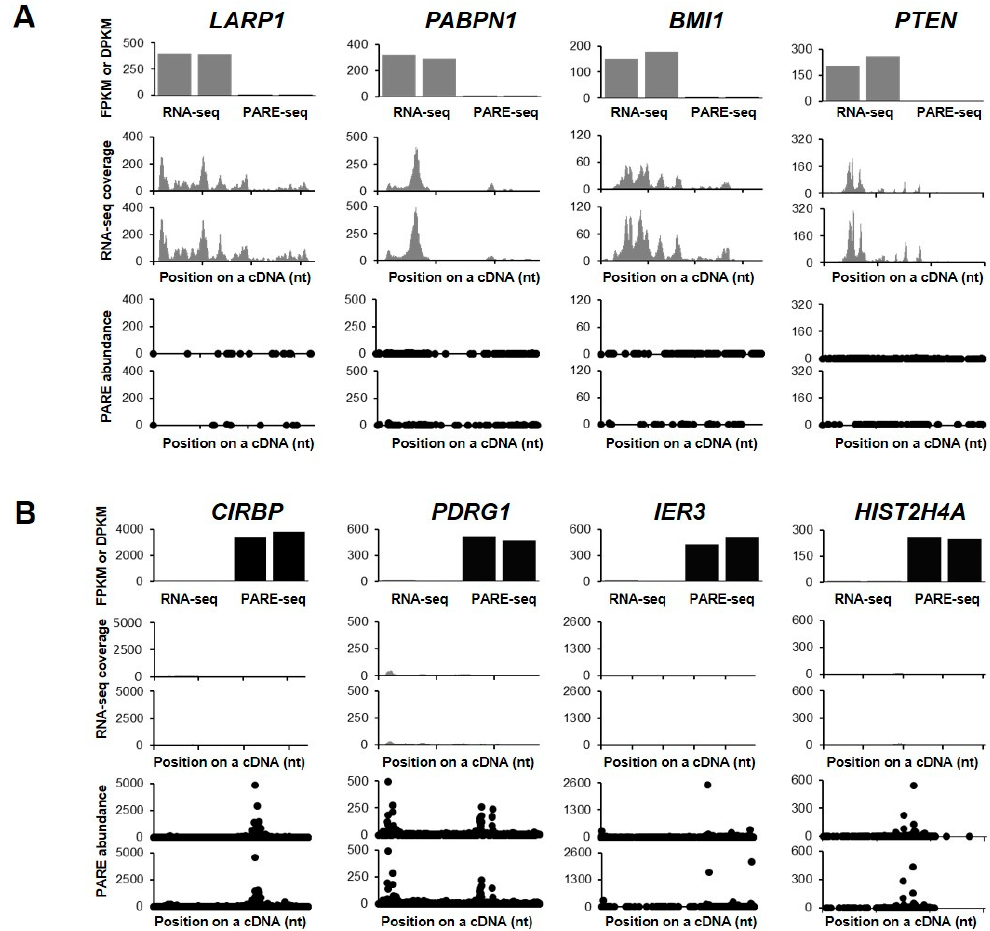
Figure 3. Selected examples of stable and unstable genes. RNA-seq and PARE-seq data for the selected stable ( A ) and unstable ( B ) genes. The first histograms represent the fragments per kilobase in million (FPKM) and decay reads per kilobase in million (DPKM) values of RNA-seq and PARE-seq data, respectively. The second histograms show the coverage of RNA-seq reads on a cDNA. The third plot is a D-plot indicating the decay patterns of PARE-seq data. The graphs are representative of two biological replicates. The X- and Y-axis represent positions on the cDNA and the normalized read depth, respectively. Grey and black colors indicate data from RNA-seq and PARE-seq, respectively.